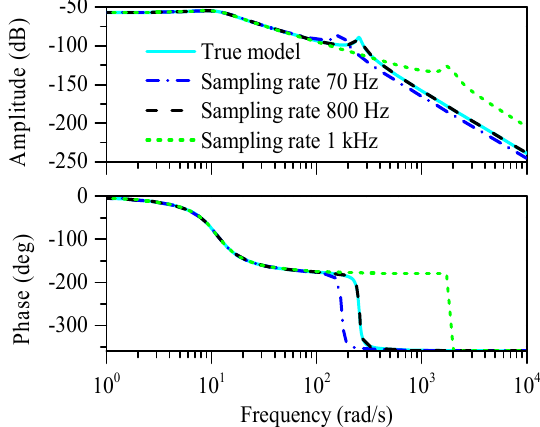
Figure 14. Bode plot of the EPS using different sampling rates.